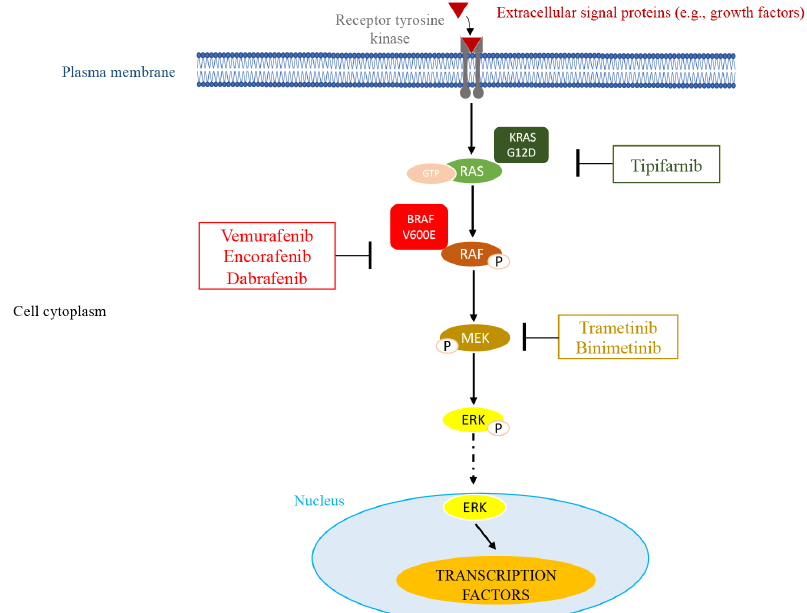
Figure 2. MAPK pathway and potential sites of therapeutic intervention with inhibitors. This molecular pathway is triggered by various extracellular signals. The main components of this pathway are RAS, RAF, and MEK leading to the activation of ERK through its phosphorylation (P). Once activated, ERK migrates into the nucleus where it activates transcription factors that affect cell proliferation and survival. In myeloma, overactive RAS/RAF/MEK/ERK signaling resulting from genetic mutations in the RAS and BRAF GTPases can be targeted by small molecule inhibitors of RAS G12D (tipifarnib), BRAF V600E (vemurafenib, encorafenib, dabrafenib), or MEK (trametinib,